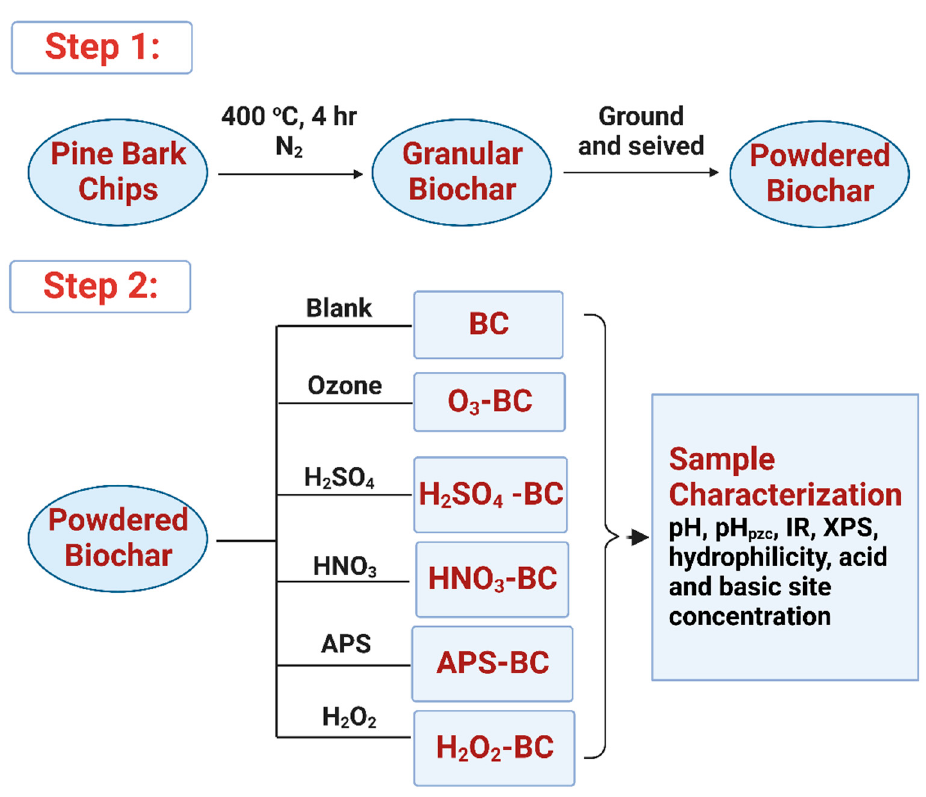
Figure 1. Schematic diagram showing the preparation and characterization techniques of biochar